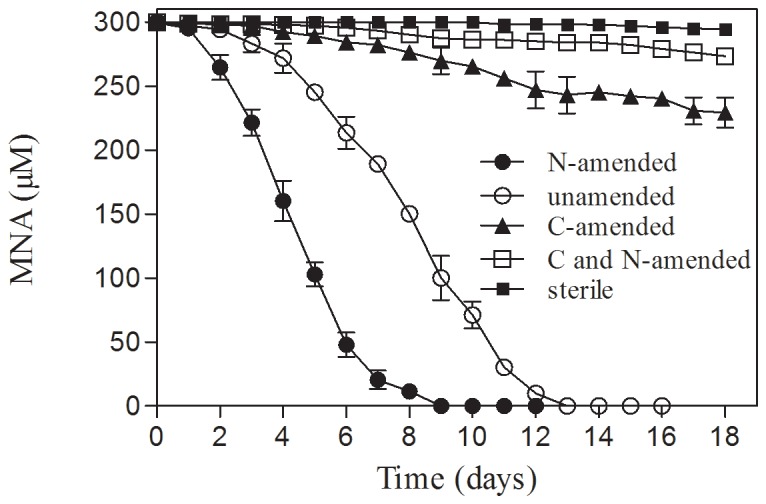
Biotransformation of MNA in soil microcosms under aerobic conditions.(•), nitrogen-amended; (○), unamended; (▴), carbon-amended; (□), carbon and nitrogen-amended; (▪), sterile. Values are presented as arithmetic mean of data obtained from experiments carried out in triplicate; error bars represent standard deviation.